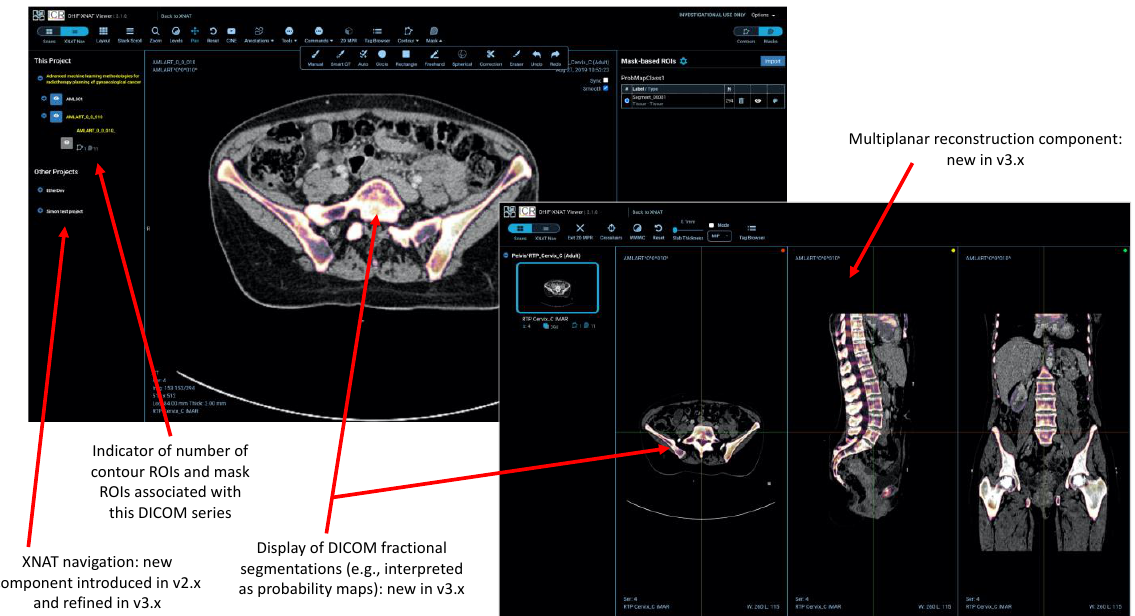
Figure 4. Display of DICOM fractional segmentation objects both in standard 2D mode and multiplanar reformatting (MPR) mode, also demonstrating the integration of a new XNAT project navigation sidebar and that 3D mask ROIs are rendered correctly in all three planes.